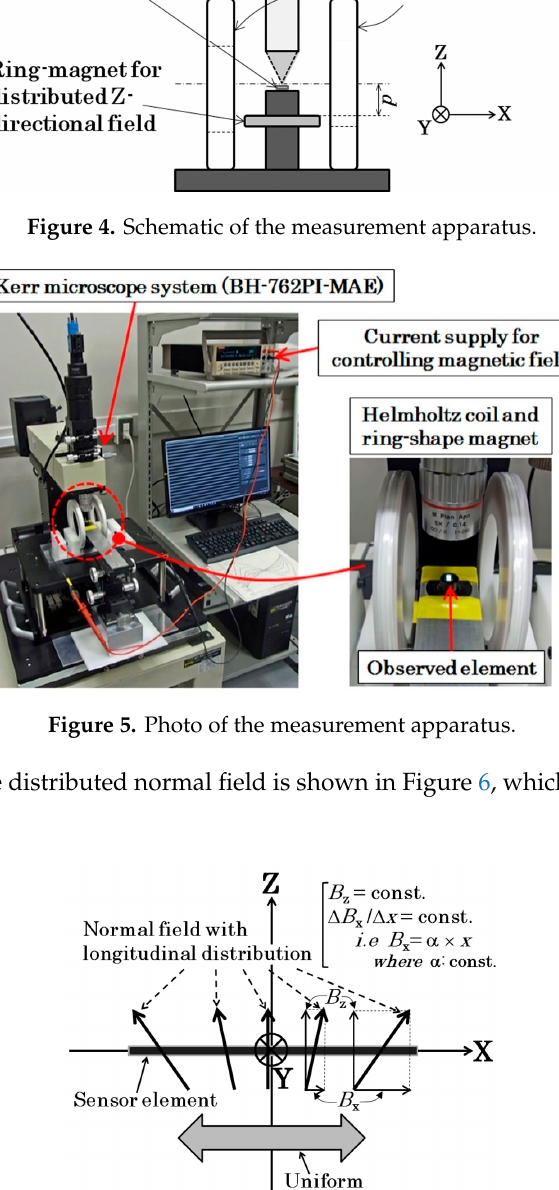
Figure 6. Definition of the distributed normal field.